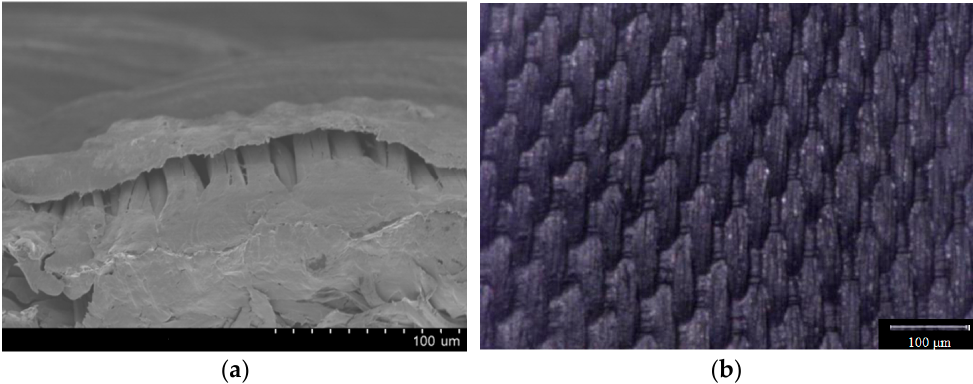
Figure 3. ( a ) Cross-sectional SEM image of the coating fabric, ( b ) coated surface of the fabric.